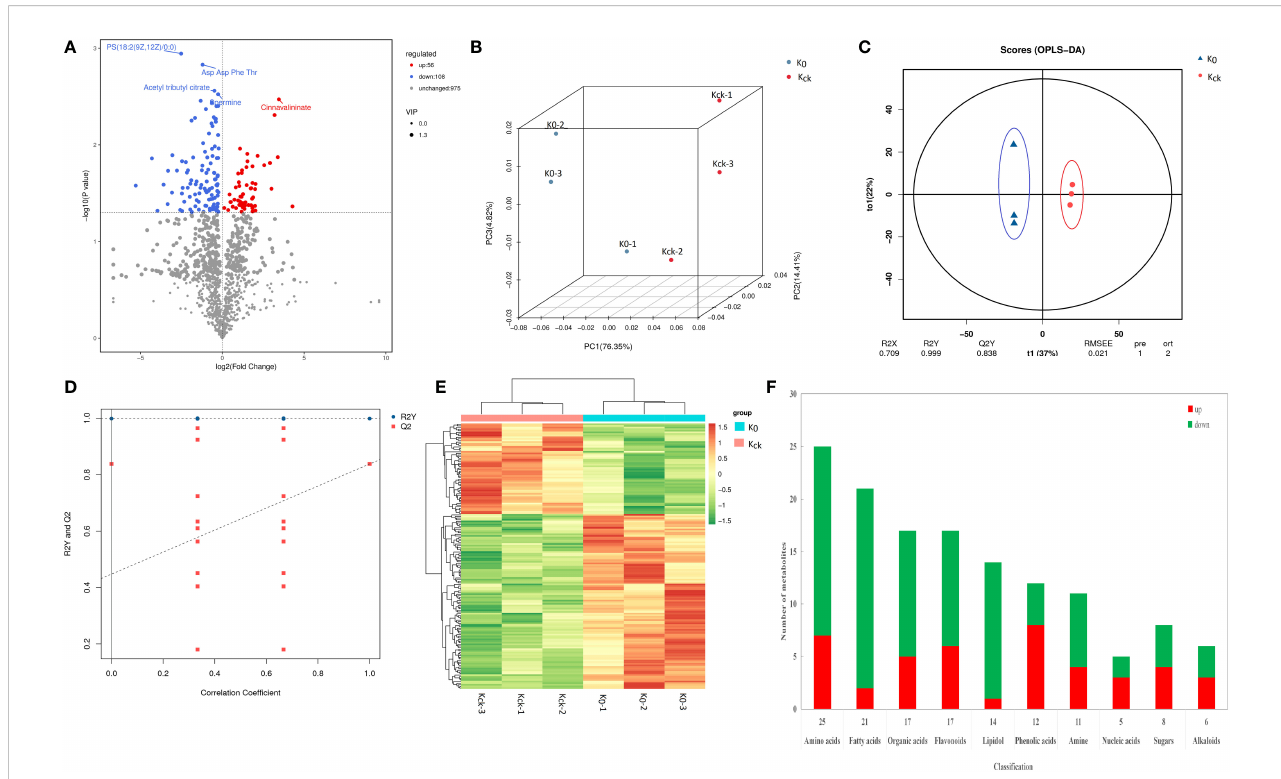
FIGURE 7 Analysis of DAMs in K 0 vs. K ck . (A) Volcano plat of the DAMs. Each dot represents a metabolite. The X-axis represents the change in each substance (Log2), the Y-axis represents the P -value of the t -test (Log10), and the scatter size represents the variable importance of projection VIPvalue of the OPLS-DA model. down-regulated DAMs are indicated in blue, up-regulated DAMs are shown in red, and metabolites with insigni fi cant differences are shown in grey. The fi rst fi ve qualitative metabolites were selected and labeled in the fi gure, based on their P -value. (B) Three-dimensional diagram of PCA. (C) OPLS-DA score model chart. R2X and R2Y represent the interpretation rate of the built model to the X and Y matrices, respectively, wherein the X matrix is the model input, i.e., the metabolite quantitative matrix, the Y matrix is the model output, i.e., the sample grouping matrix, and Q2 represents the prediction ability of the model, i.e., whether the built model can distinguish the correct sample grouping based on metabolite expression. The closer R2Y and Q2 are to 1 in the index, the more stable and reliable the model is. This model can be used to screen DAMs. Generally, Q2 > 0.5 indicates an effective model, and Q2 > 0.9 re fl ects an excellent model. (D) OPLS-DA model validation chart. The X-axis represents the similarity with the original model, the Y-axis represents the value of R2Y or Q2 (where R2Y and Q2 taken as 1 in the abscissa are the values of the original model), the blue and red points represent R2Y and Q2 of the model after Y replacement, respectively, and the dotted line is the fi tted regression line. (E) Clustering heat map of the 164 DAMs. (F) Histogram of classi fi cation changes of different